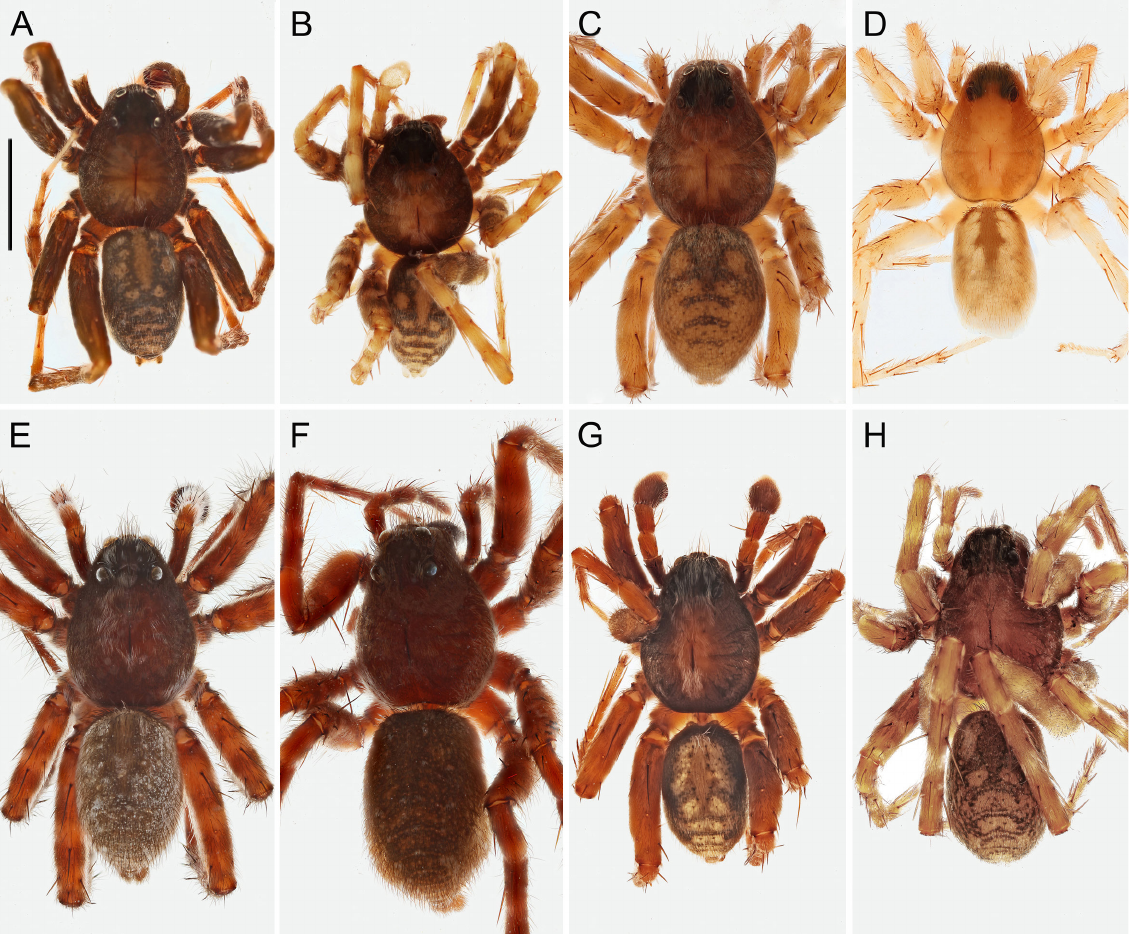
Fig. 1. Habitus, dorsal view. — A – C . Wadicosa benadira (Caporiacco). A ♂ from Kenya, Marsabit. B ♂ and C ♀ from Kenya, WNW of Mombasa. — D . W. russellsmithi sp. nov., holotype, ♀. — E – F